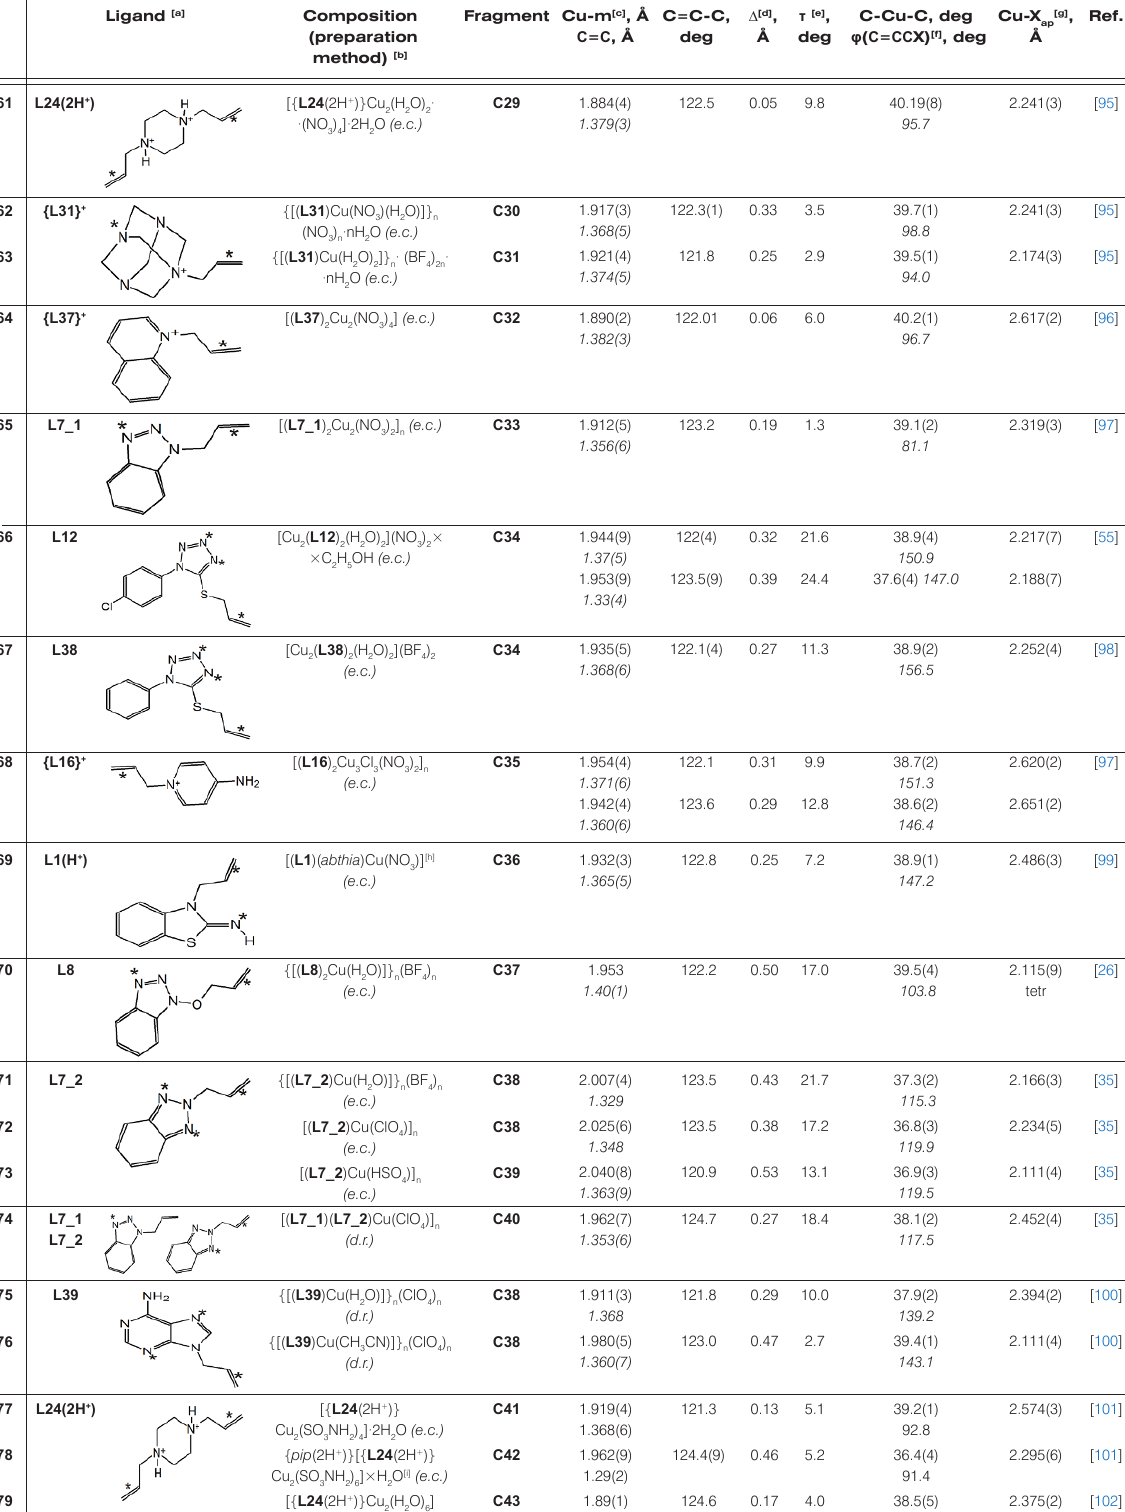
Table 2. Geometric parameters of Cu(I) π -core in the structures of complexes with ionic copper(I) salts. Ligand